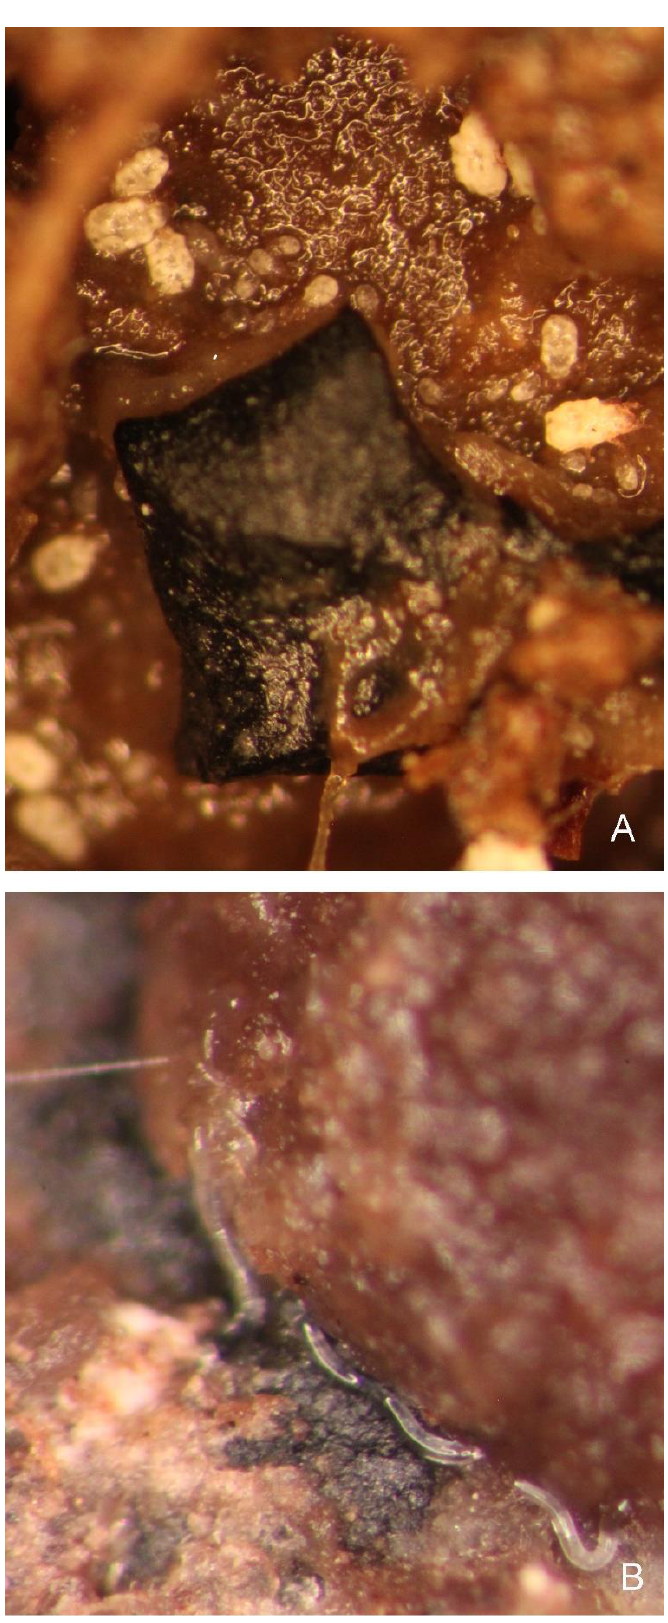
Figure 3. Tuber aestivum . ( A ) Acarina Zerconopsis remiger on surface of fungi. ( B ) Nematodes on surface of truffle near a cup of cocoon made by larva of Leiodes cinnamomea .